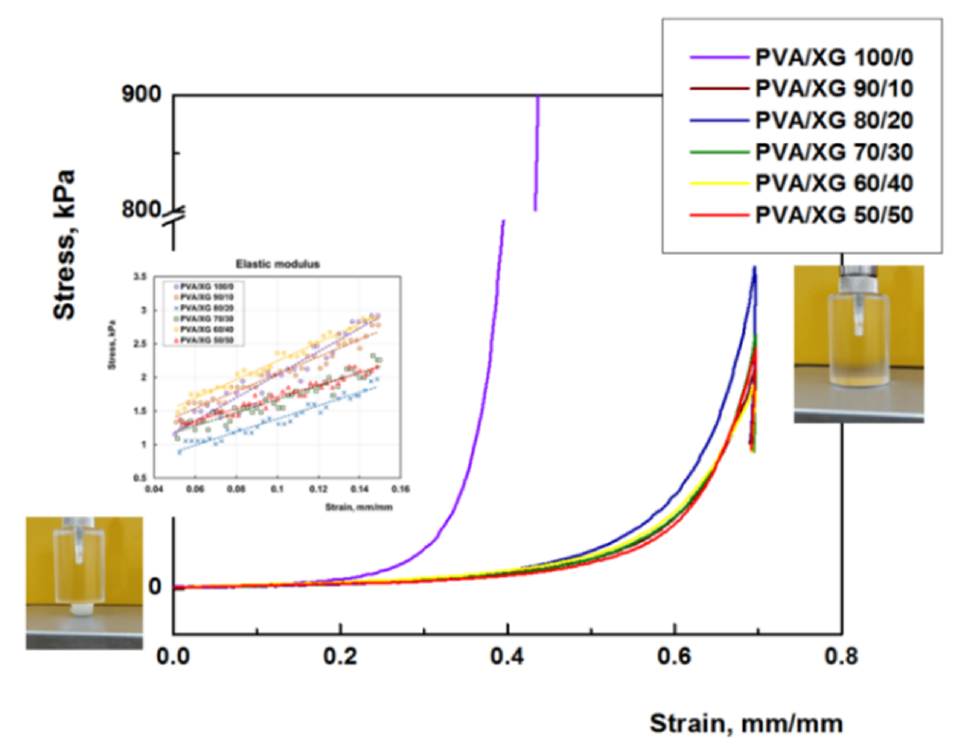
Figure 8. Typical stress − strain curves for hydrogels prepared with different ratios between PVA and XG; the insets present the linear dependence of stress − strain curves between 0.5 and 15% compressions, which was used to calculate the elastic modulus of all hydrogels; optical pictures of swollen PVA/XG hydrogel during the uniaxial compression test.